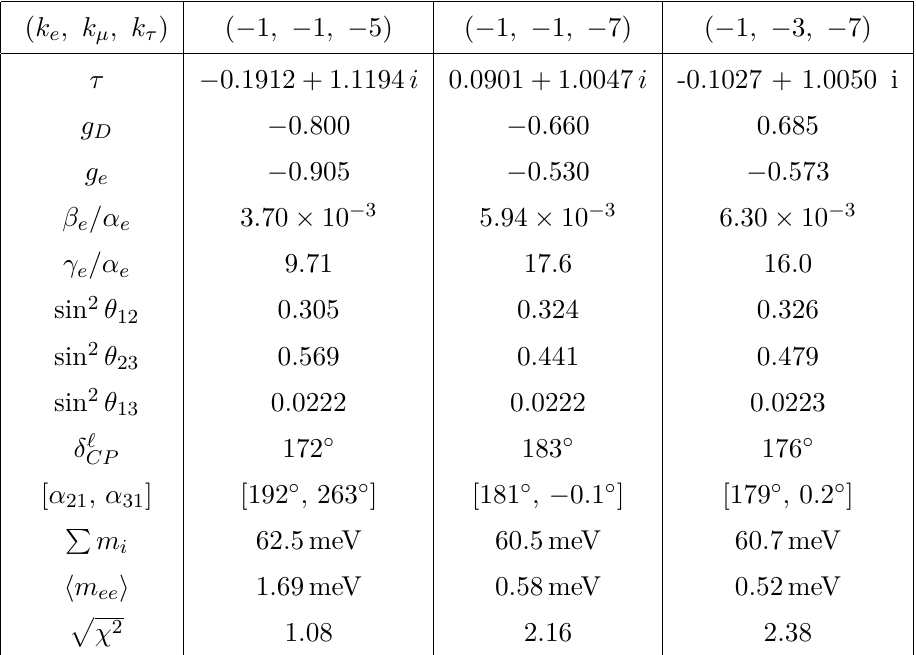
Table 7 . Numerical values of parameters and observables at sample points of